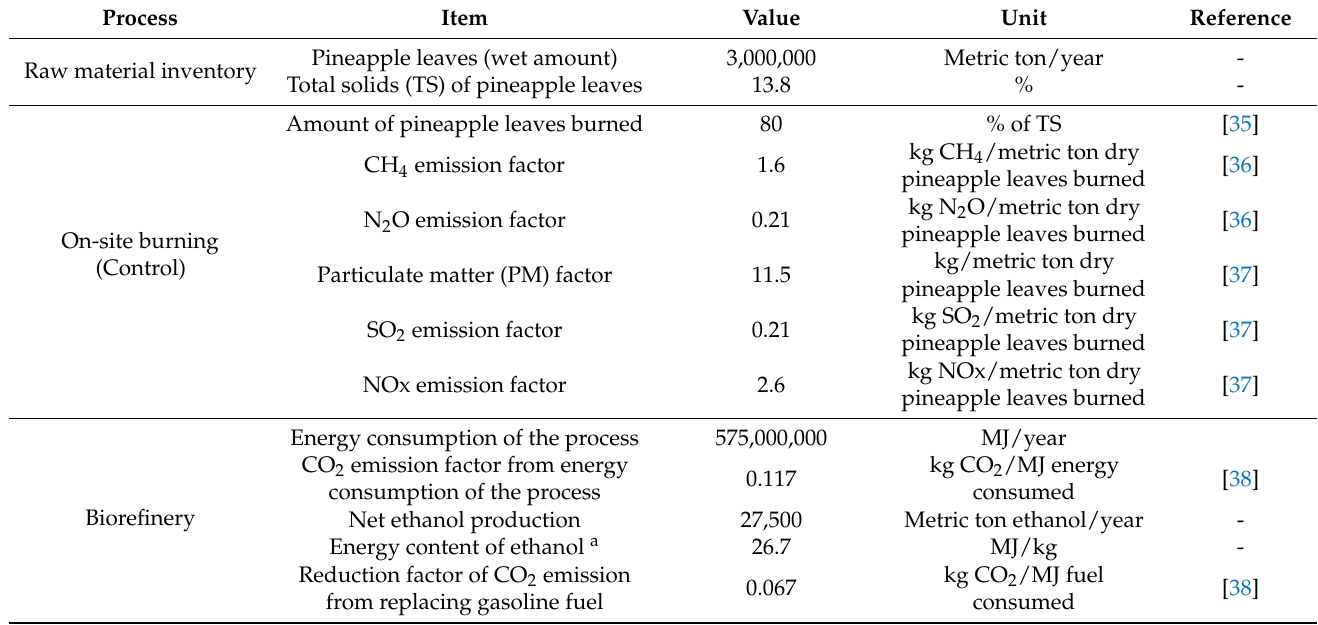
Table 6. Life cycle inventory of the biorefinery and on-site